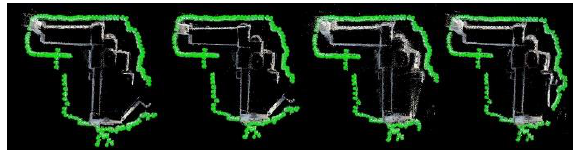
Figure 1: Camera poses retrieved by Pix4D in various tests keeping the same processing settings and just changing the order of the images. DATASET 3 – Sarcophagus (514 images) PS